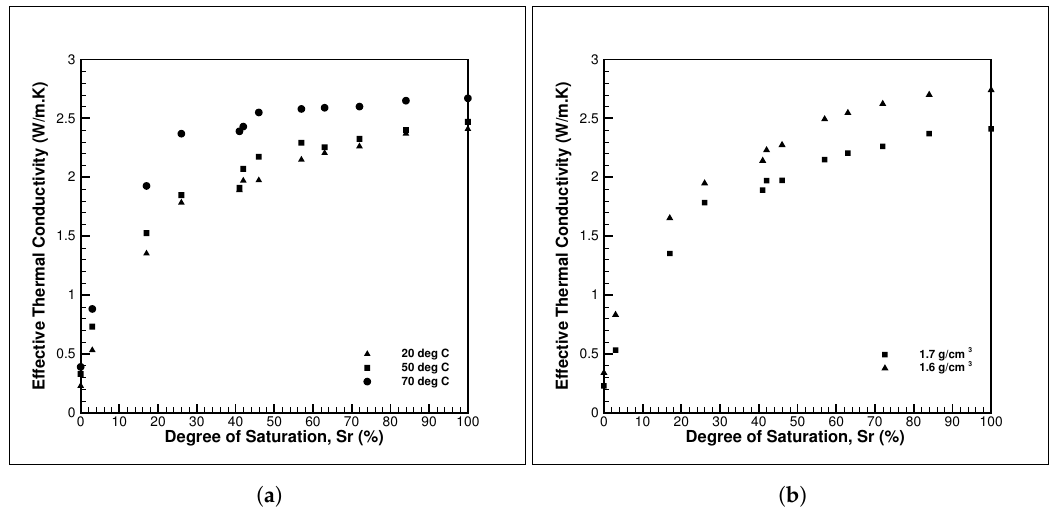
Figure 5. Thermal properties of sand ( a ) plot of thermal conductivity vs. saturation for three different temperature values of 20 °C, 50 °C and 70 °C; ( b ) saturation dependent thermal conductivity at two density